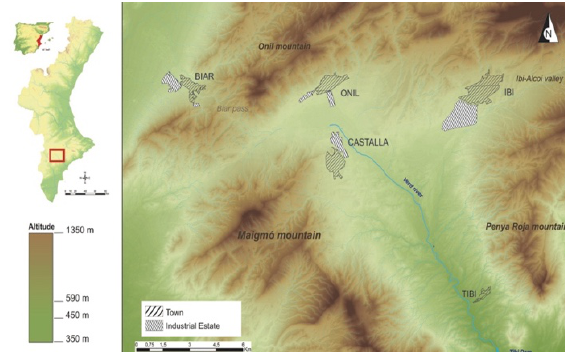
Figure 1. Geographical location of Castalla (Iberian Peninsula, Valencian Community and Foia de Castalla district).